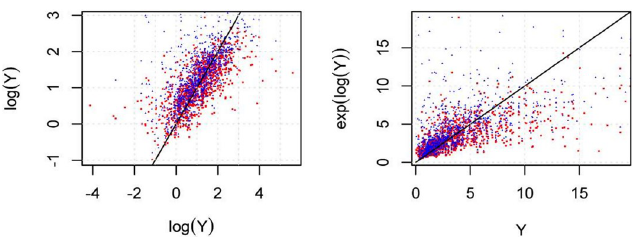
Fig 2. Simulated response vs . estimated